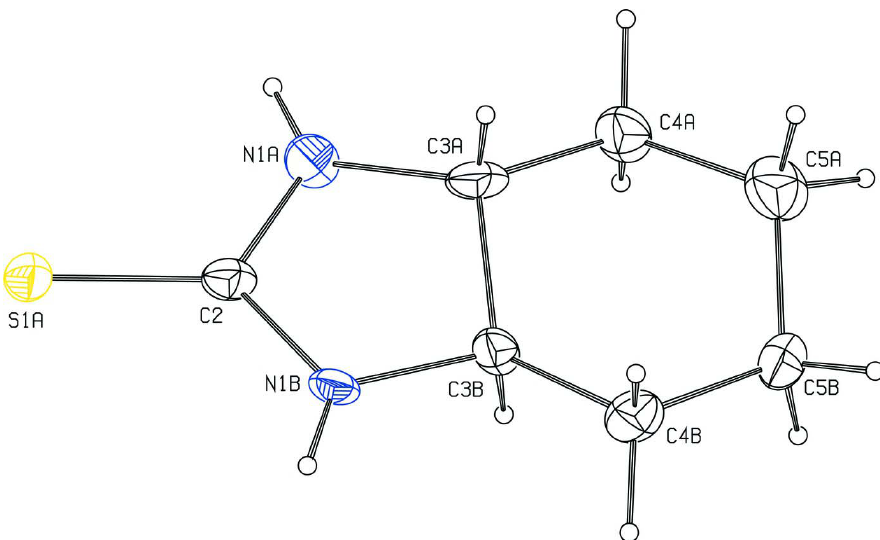
Figure 1 View (S,S)-isomer of (I) showing the atom-labelling scheme. Displacement ellipsoids are drawn at the 30% probability